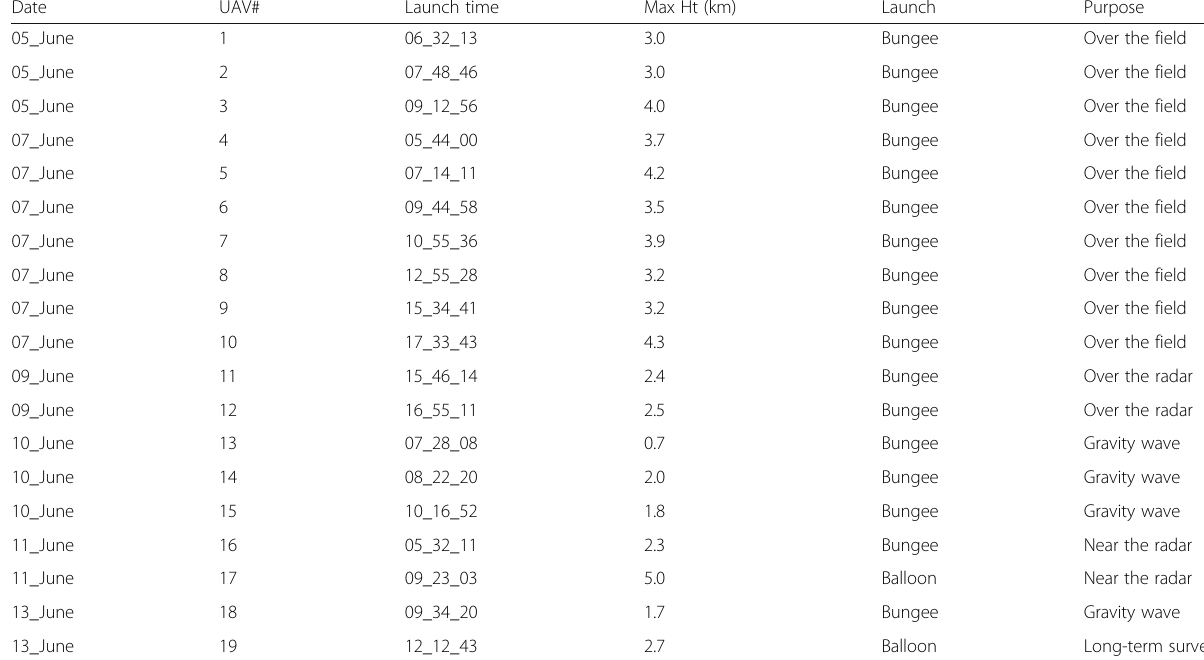
Table 3 Catalog of science flights during the ShUREX 2015